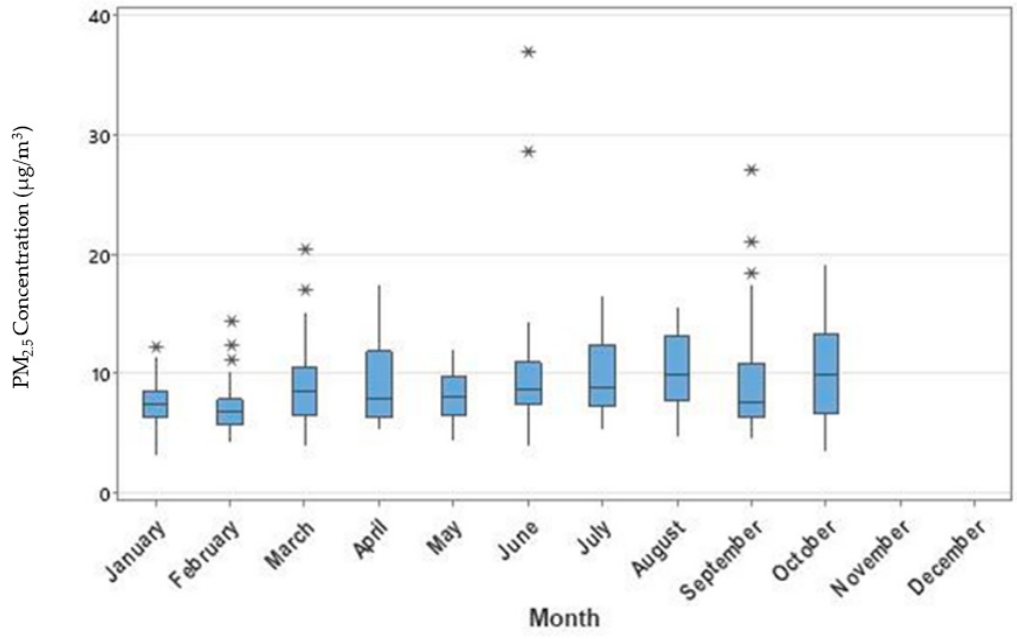
Figure 2. Boxplot of monthly PM 2.5 concentrations ( µ g/m 3 ) in 2020 (January–October). The * symbol represents values that were considered outliers for that particular month.